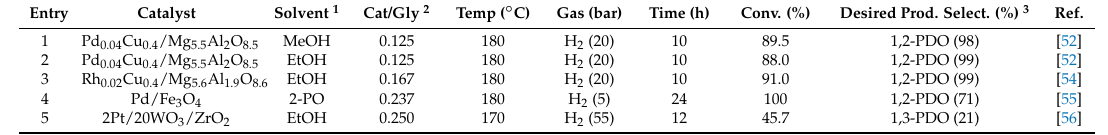
Table 2. Hydrogenolysis of glycerol in presence of H-donor